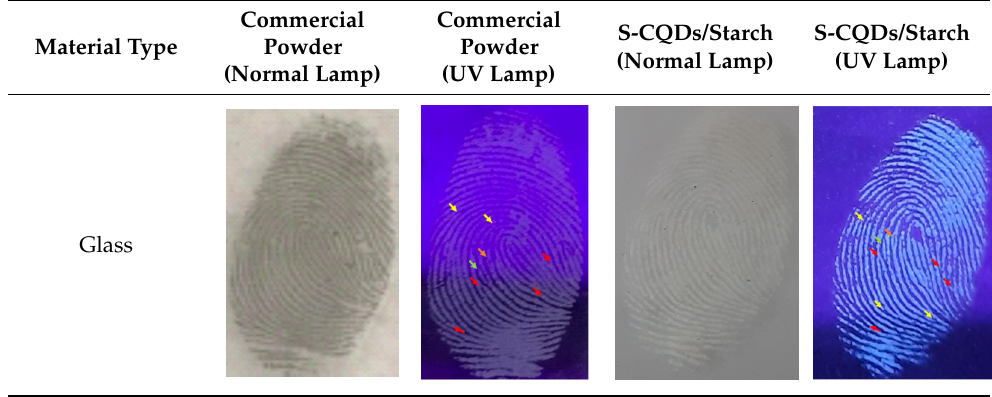
Table 3. Detection of latent fingerprints on a glass surface using S-CQDs/starch vs. commercial powder under normal and UV lamps.